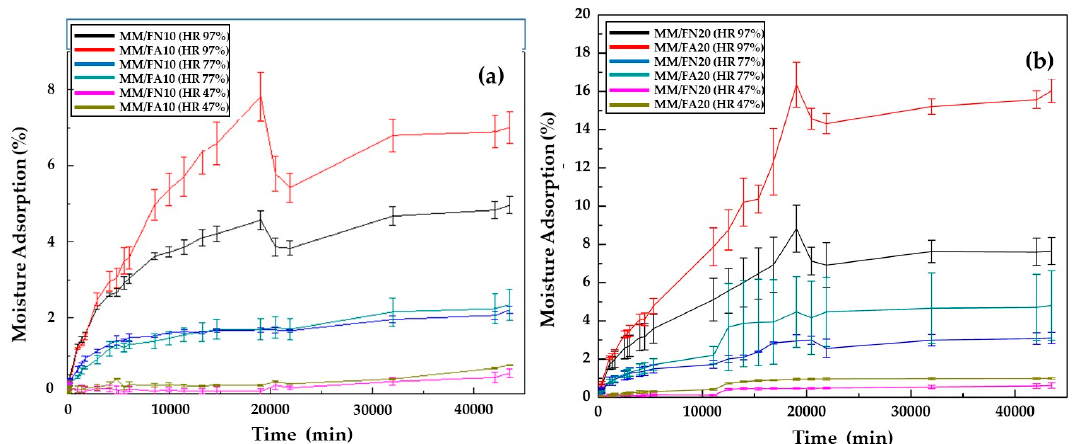
Figure 5. Adsorption isotherms at relative humidities of 97, 77, and 47 for ( a ) biobased composite with 10% native and alkalized fique fibers; ( b ) biobased composite with 20% native and alkalized fique fibers.